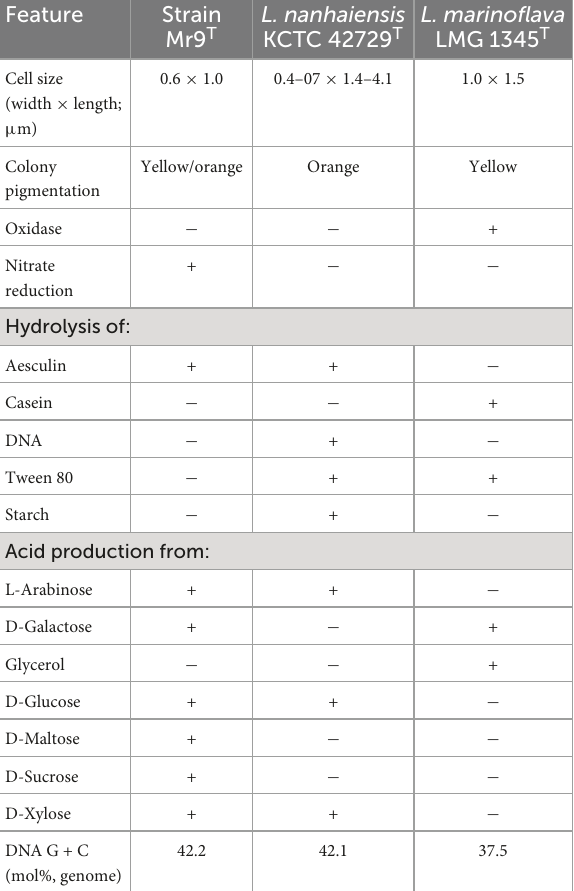
TABLE 1 Differential features of strains: Mr9 T , Leeuwenhoekiella marinoflava LMG 1345 T , and L. nanhaiensis KCTC 42729 T . Feature Strain Mr9